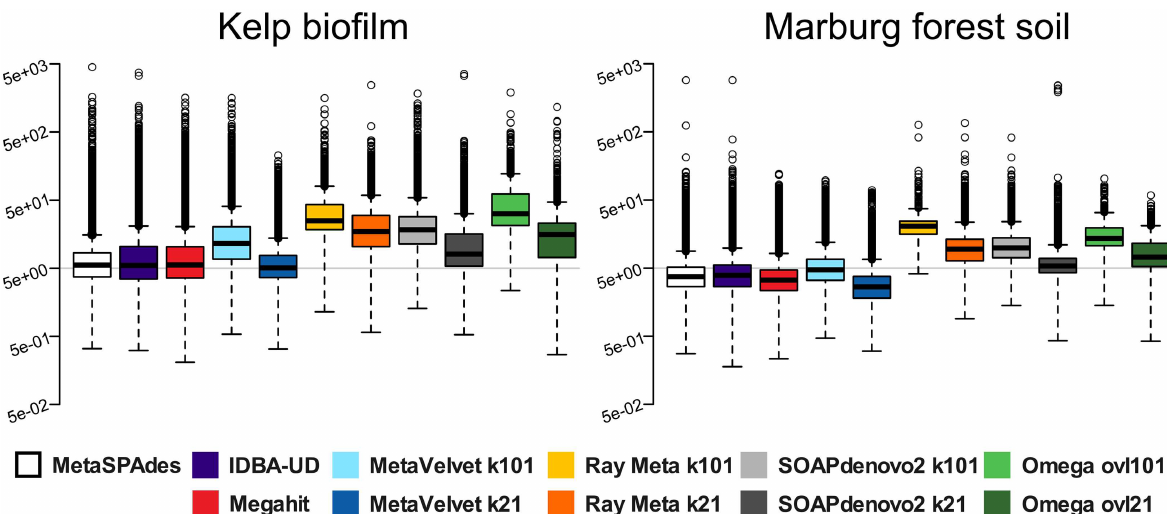
Fig 4. Coverage distribution of assembledscaffolds produced by different assemblers. Kelp biofilm (KBF) assemblies are shown on the left and Marburg forest soil (MFS) assemblieson the right. The boxplotsillustrate the relative abundances of scaffolds with different coveragevalues in the assembleddatasets. Coveragevalues are basedon the depth of reads mappingback to the assembled scaffolds > 500 bp and were evaluatedseparately for each assembly and sample using the short read mappingtool Bowtie2 and quality-trimmed pairedend reads. A logarithmic scale was chosen for the y-axis in order to account for extreme outliers. For better comparability, grey background lines mark the height of 5x coverage.